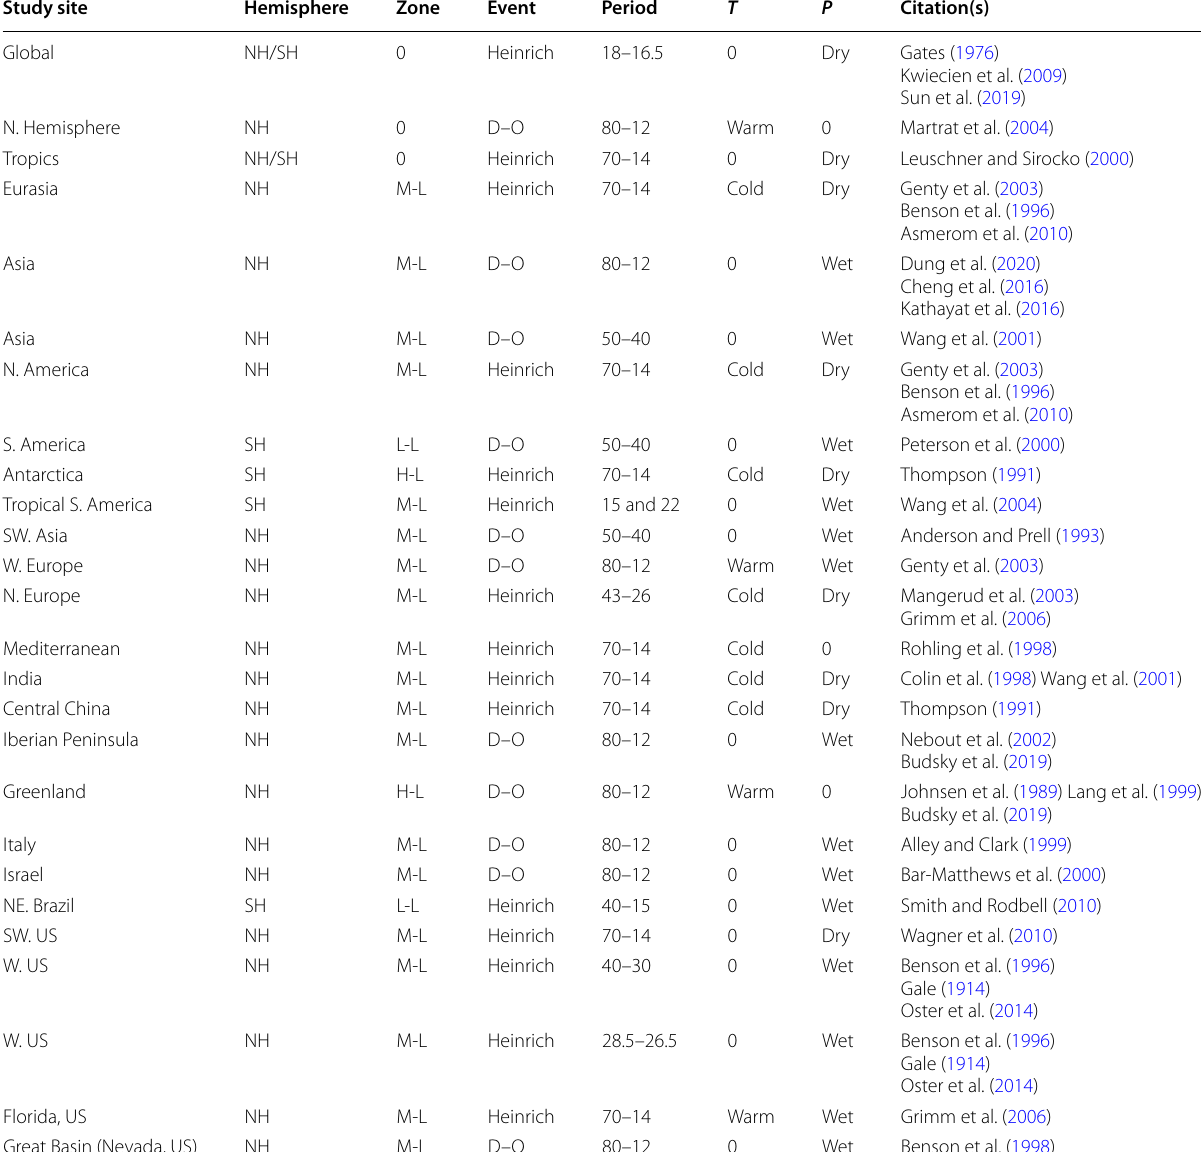
Table 4 Temperature and precipitation conditions during the Last